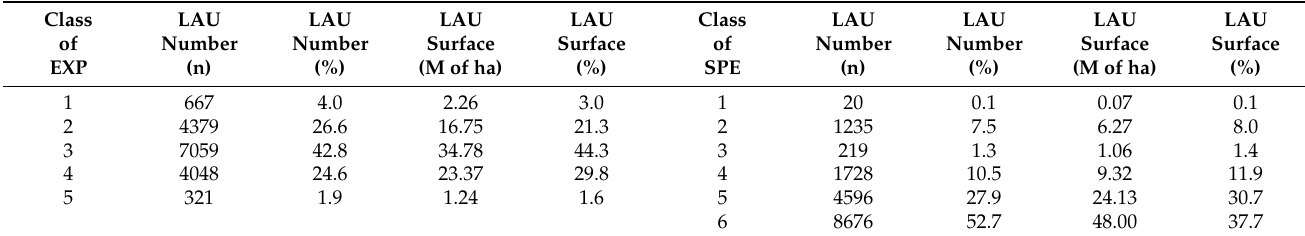
Table 6. Number and surface of LAUs falling in each class of the two indices (EXP and SPE) and relative percentage calculated on the total values for the first census date (C1). Class of